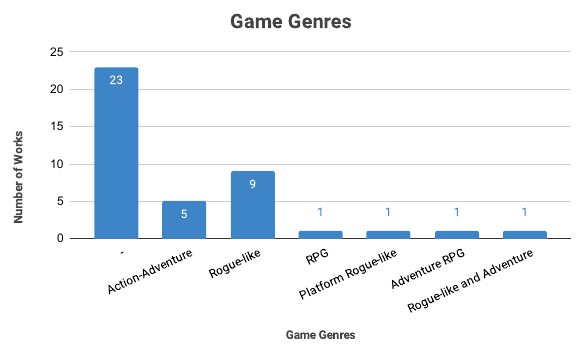
Figure 10. Number of works by game genre.